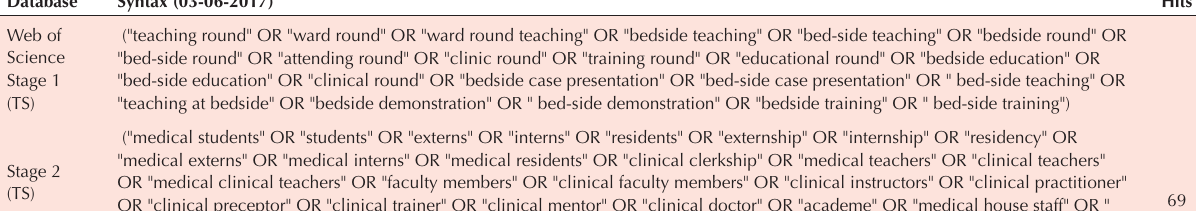
Table 1. Search syntax for Web of Science, PubMed, Embase, Scopus, and Cochrane library